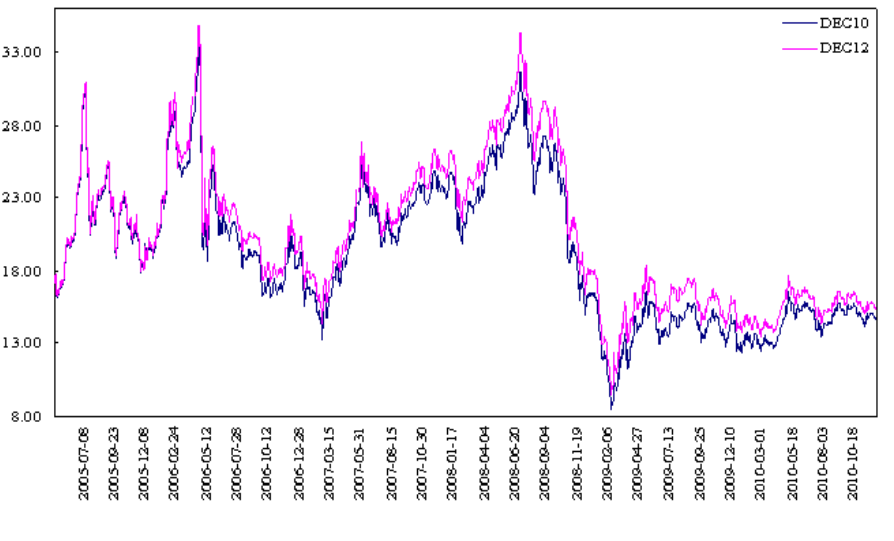
Figure 3. DEC10 and DEC12 from April 22, 2005 to December 3,